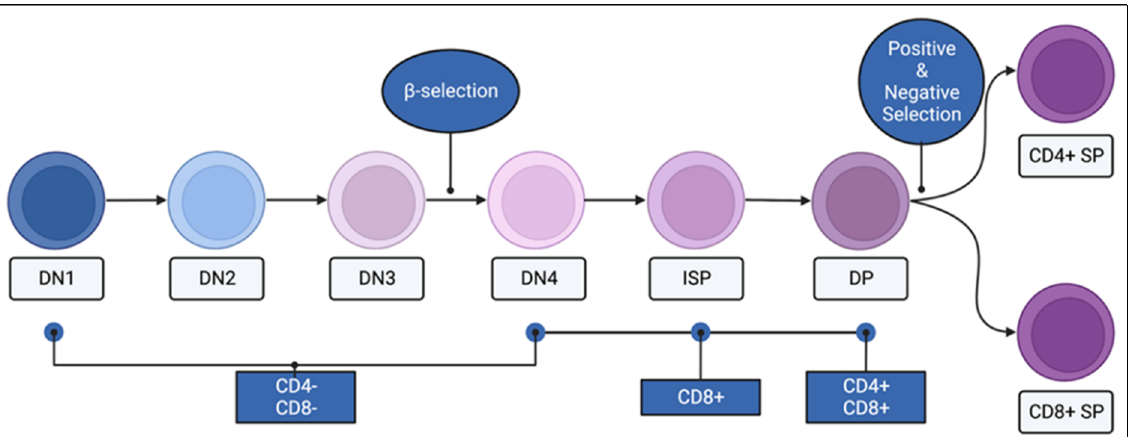
Figure 4. CD4 and CD8 expression of thymocytes through maturation. Immature thymocytes begin the process of maturation in the thymus in the double negative (DN; CD4 − CD8 − ) stage, followed by DN2, DN3, and DN4 stages. The process of β -selection takes place as DN3 thymocytes mature into the DN4 stage. In mice, DN4 thymocytes transition through an immature single positive (ISP, CD8+) stage to become double positive (DP; CD4+ CD8+) thymocytes. The second round of selection, positive and negative selection, takes place between the DP and the mature single positive (SP) stages. Mature SP thymocytes can be CD4+ or CD8+. Created with BioRender.com.